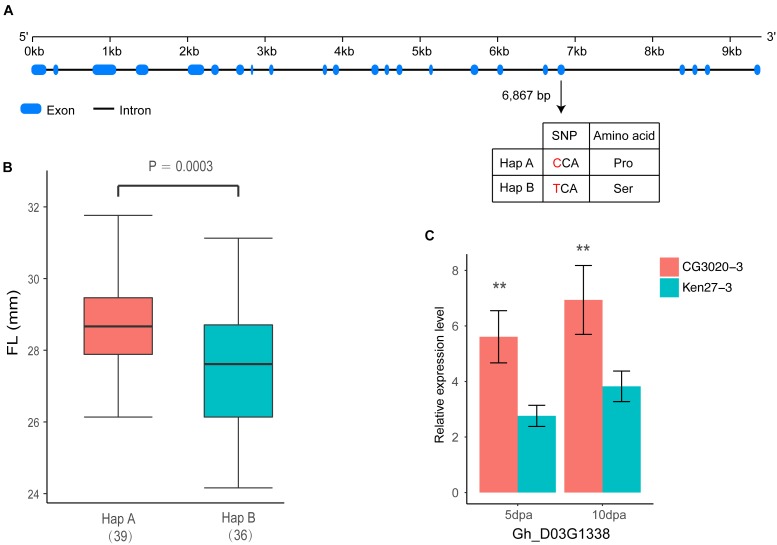
Identification of the FL causal gene Gh_D03G1338 on chromosome D03. (A) Exon–intron structure of Gh_D03G1338 and the polymorphism in two haplotypes with the ‘C’ and ‘T’ alleles. (B) Box plot of FL based on the two haplotypes mentioned above (n = 39 versus 36). Differences between the haplotypes were analyzed by two-tailed Student’s t-tests. (C) Comparison of expression levels of Gh_D03G1338 during fiber development stages by qRT-PCR (∗∗indicates significance at the 0.001 probability level).